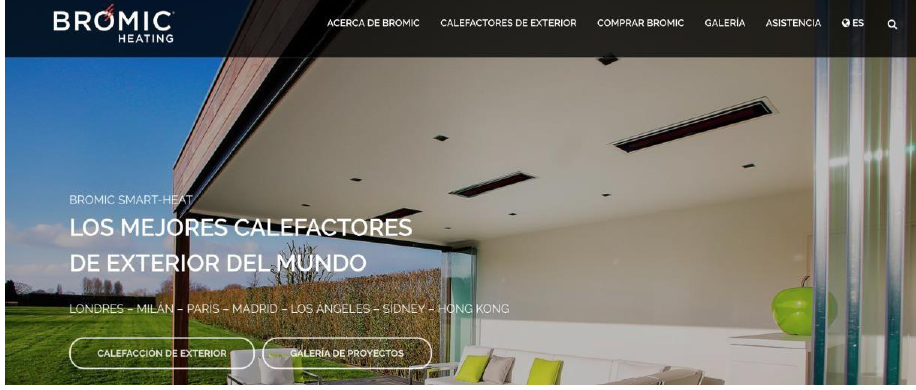
Figure 3: Bromic’s Spanish language website, readily accessible to potential Chilean